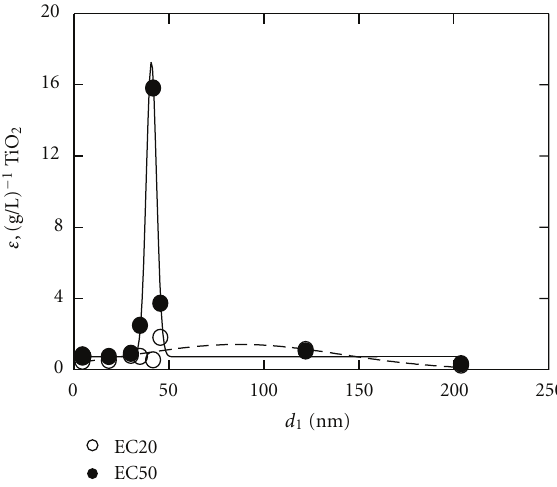
Figure 6: Critical specific lipid peroxidation ( ε ) as a function of primary particle size in terms of EC20 and EC50. Line is fitted 3- parameter Gaussian equation (8) in SigmaPlot ver. 9.01 for EC20 (dotted) and EC50 (solid). Experimental conditions: initial algae concentration = 1 . 4 ± 0 . 9 × 10 6 cell/mL, test duration = 4 days, and initial test volume = 200